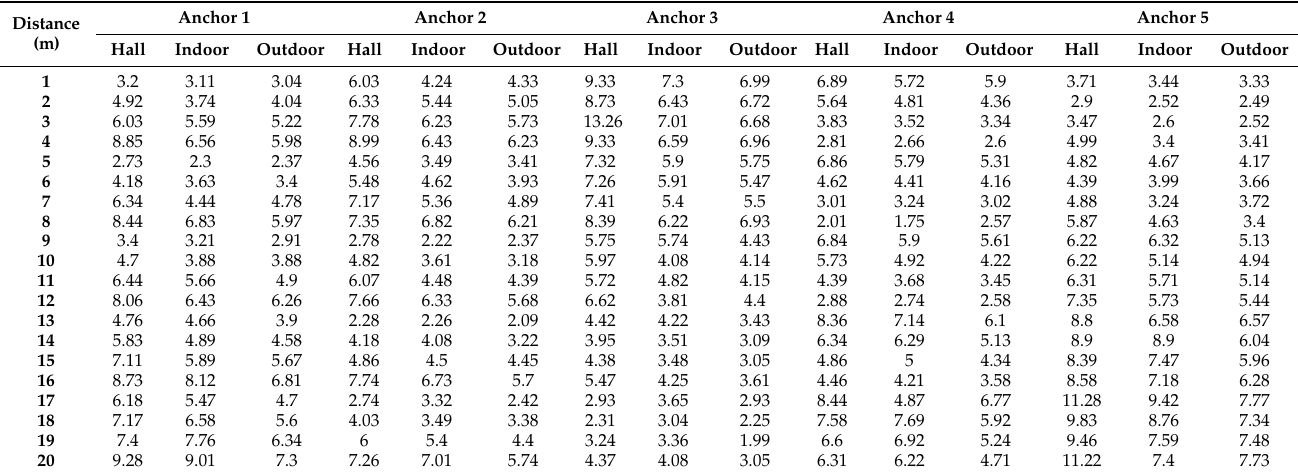
Table 4. The distances obtained from anchor